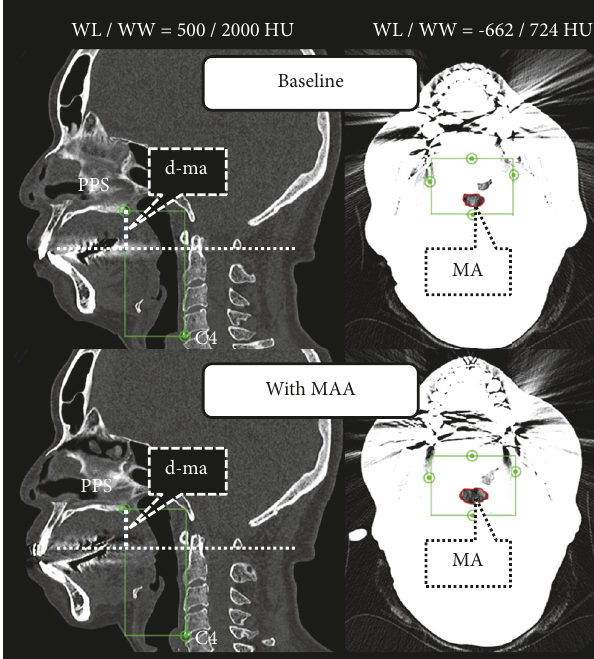
Figure 3: The minimum area (MA) on multiplanar reconstruction (MPR) images. The slice datasets were coordinated as follows: (1) The median sagittal cross-sectional image was set by using the baseline (T1) data (window level/window width [WL/WW] was set to the CT- bone value of 500/2000 HU). (2) The craniocaudal direction was set with the upper end as the palatal pharyngeal space (PPS) and the lower end as the lowermost anterior point of the fourth cervical vertebrae (C4) on the MPR image by verifying on the median sagittal, axial, and coronal cross-sectional images. (3) The WL/WW was set to the airway component value of -662/724 HU, the site where the cross-sectional area within that range was the narrowest by verifying on the axial cross-sectional image was set as the MA, and the anteroposterior diameter, width, and cross-sectional area were measured. (4) The WL/WW was again set to the CT-bone value of 500/2000 HU, and the vertical distance (d-ma) from the PPS to the MA was measured on the median sagittal cross-sectional image. (5) The median sagittal cross-sectional image was set using data with the mandibular advancement appliance (MAA), and each d-ma obtained from the baseline data was reproduced as multislice computed tomography (MSCT) data with MAA. (6) The WL/WW was set to the airway component value of -662/724 HU, and the anteroposterior diameter, width, and cross-sectional area were measured by verifying on the axial cross-sectional image.